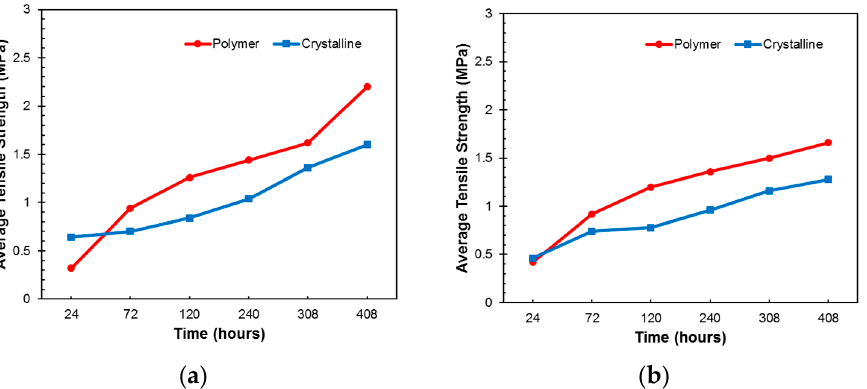
Figure 19. The relation between the average tensile strength (pull-off strength) and time for the polymer and crystalline coating: ( a ) rough substrate, ( b ) smooth substrate (based on the results presented in Reference [70]).